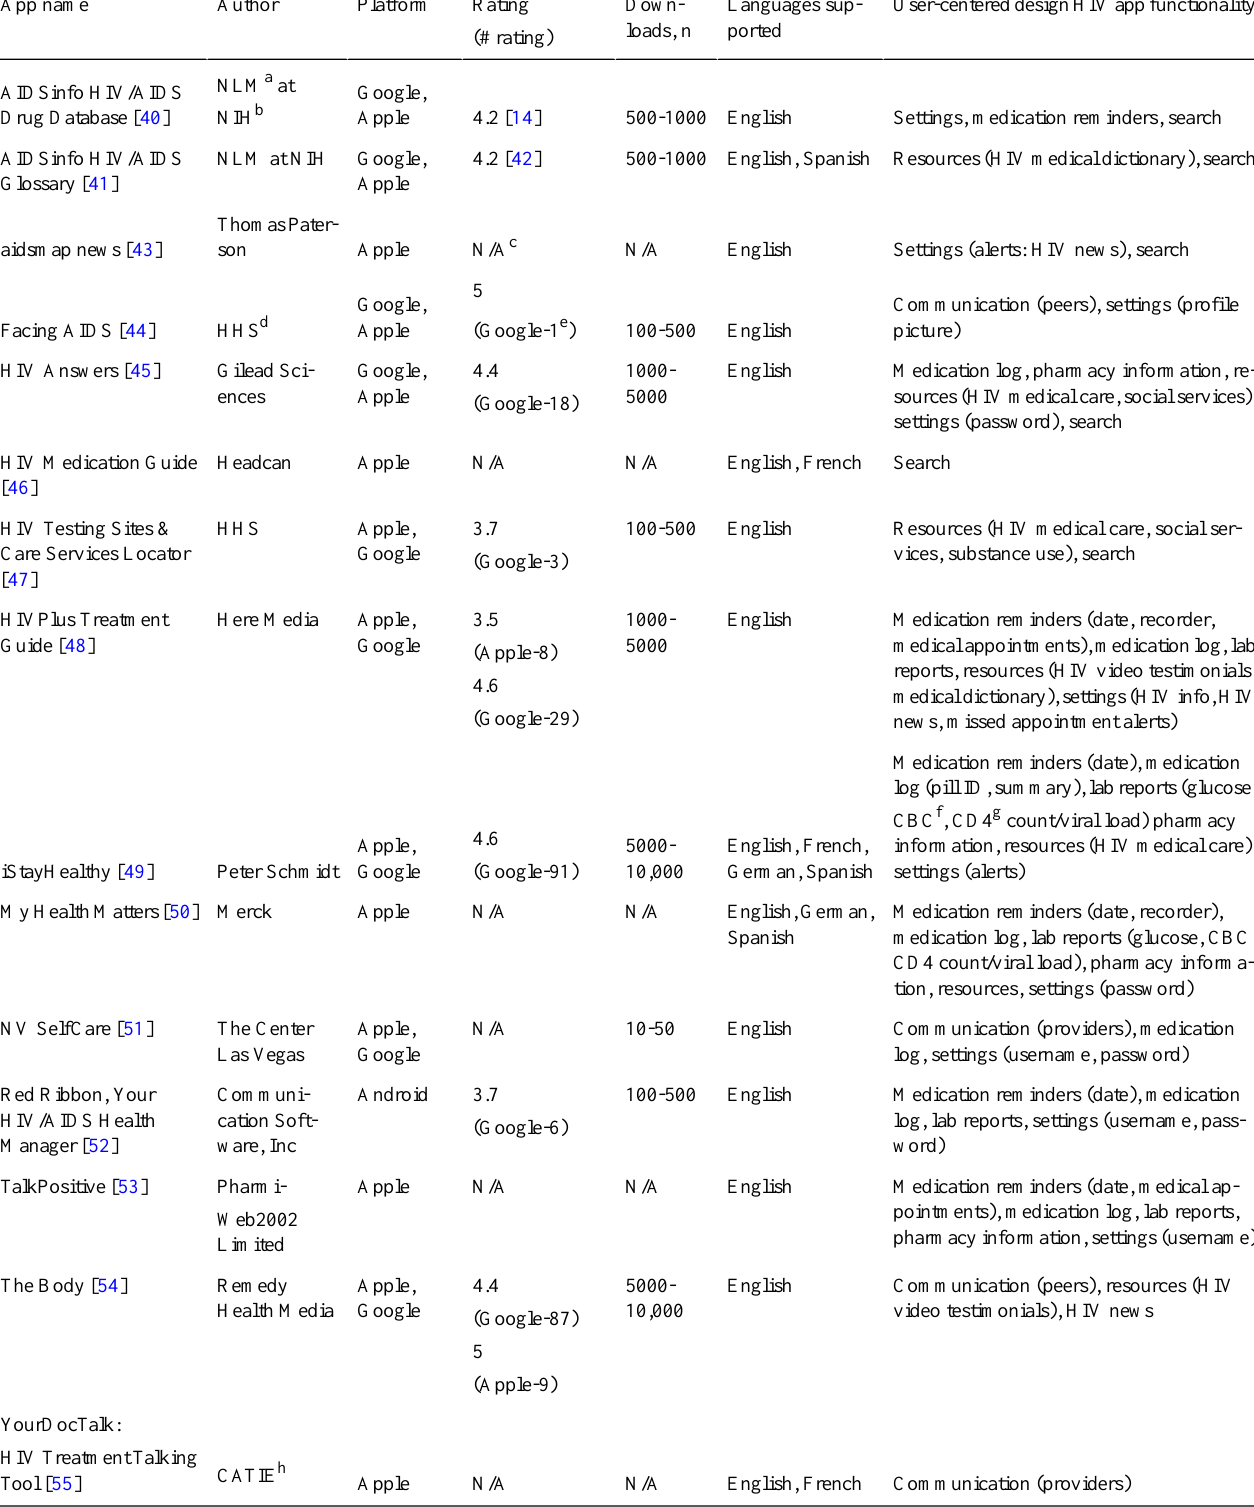
Table 2. Overview of 15 apps for persons living with